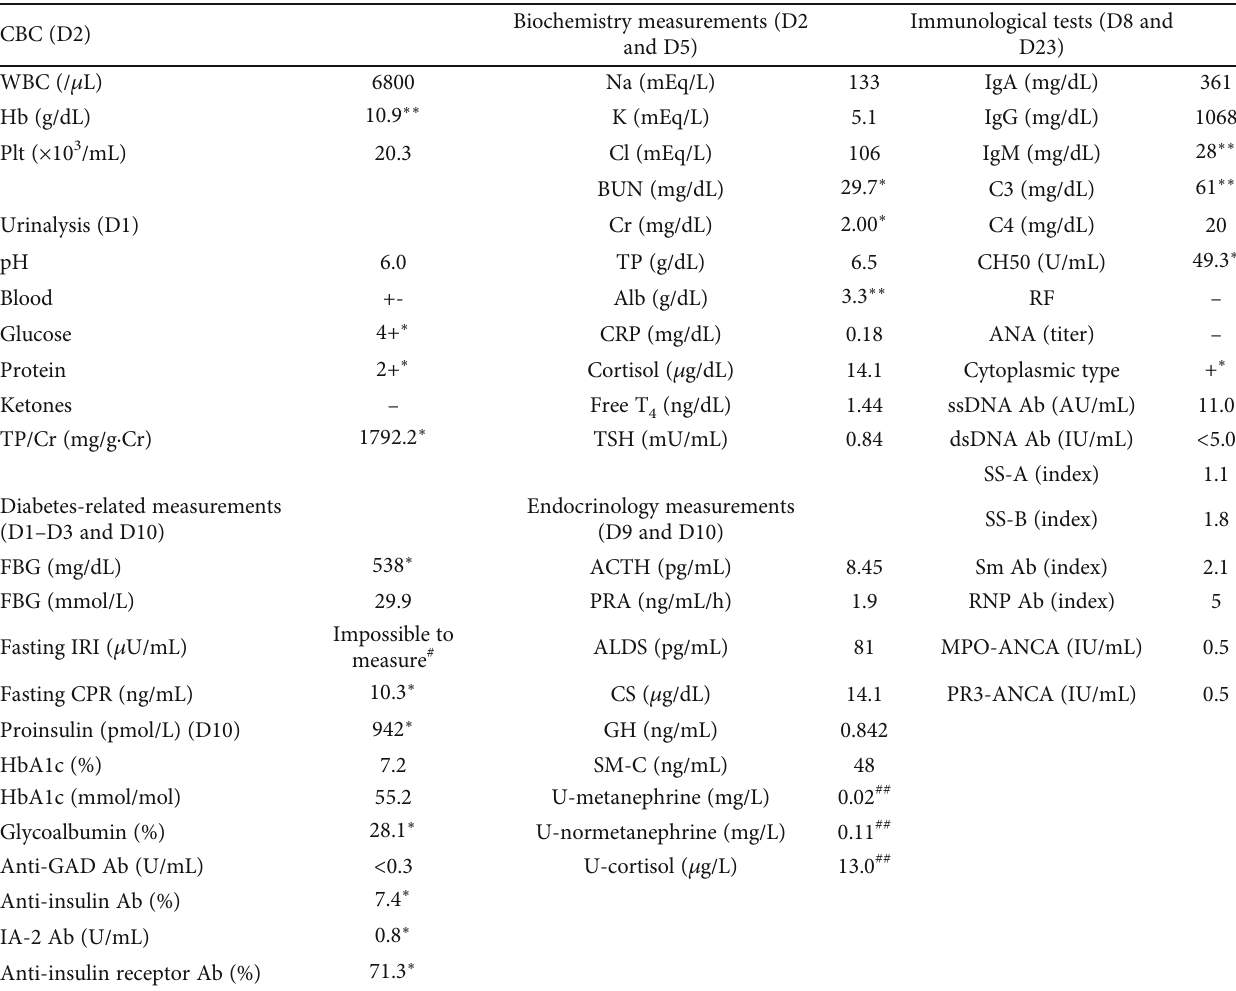
Table 2: Laboratory fi